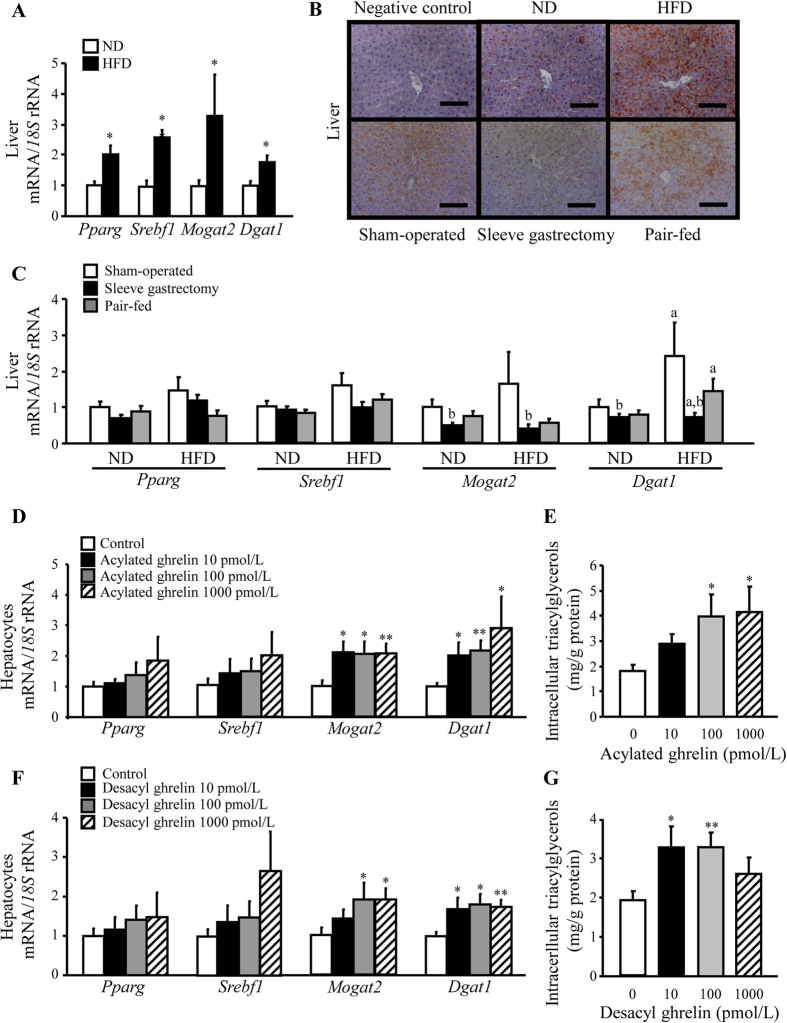
Effect of acylated and desacyl ghrelin on the improvement of hepatic steatosis after sleeve gastrectomy.Impact of obesity (A) and sleeve gastrectomy (C) on the mRNA expression levels of Pparg, Srebf1, Mogat2 and Dgat1 in liver samples of experimental animals. (B) Immunohistochemical detection of adipophilin in histological sections of rat liver (magnification 200x, scale bar = 100 μm). Effect of acylated (D,E) and desacyl (F,G) ghrelin on key lipogenic factors and intracellular triglycerides in rat hepatocyte cultures. The gene expression in lean rats, in the sham-operated groups fed a ND and in unstimulated hepatocytes was assumed to be 1. *P < 0.05; **P < 0.01 vs lean control ND or unstimulated hepatocytes; aP < 0.05 effect of diet; bP < 0.05 effect of surgery.